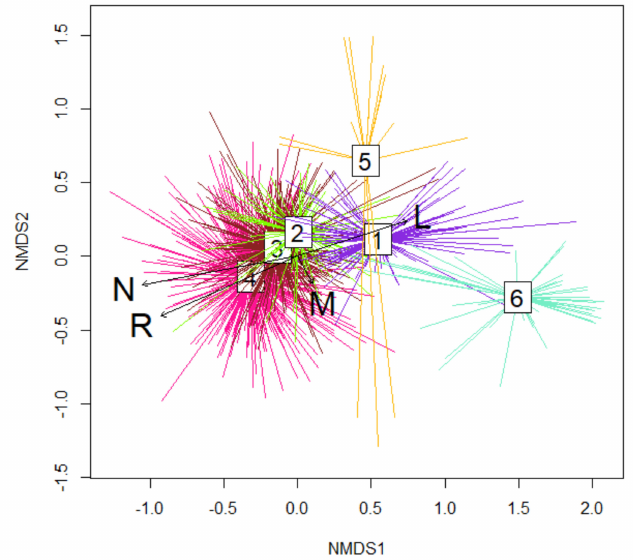
Figure 7. Distribution of coniferous communities in NMDS ordination axes. Groups of communities: look captions for Table A1.